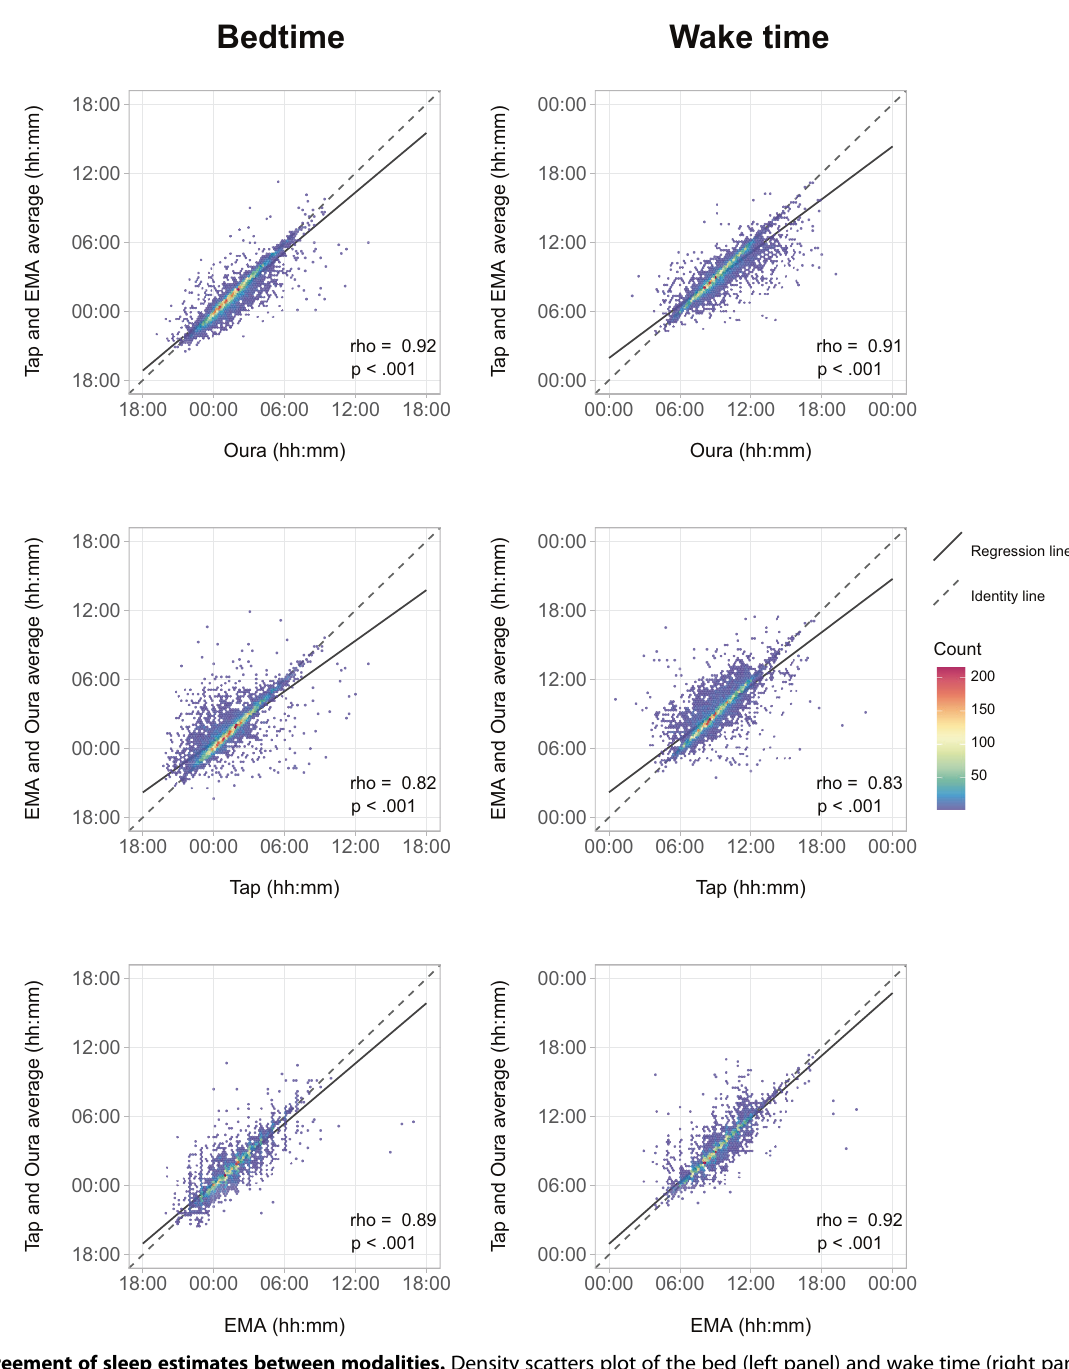
Fig. 2 Agreement of sleep estimates between modalities. Density scatters plot of the bed (left panel) and wake time (right panel) estimates from each modality ( x -axis) against estimates obtained from the average of the other two modalities ( y -axis). Correlation coef fi cients are stated for each of the subplots (nights with all three modalities, n = 7581). The dashed line indicates the identity line where there is complete agreement between cluster solutions remained stable when a range of different discrepancy thresholds was used (1.5, 2, and 2.5 h; see Supple- mentary Fig. 1 and Supplementary Table 1). Cluster 1 ( n = 467) consisted of nights with delayed sleep timings across all modalities and later Oura wake times relative to the other clusters. From the corresponding discrepancy data, we observed that Oura ’ s wake time estimates for this cluster were later in comparison to the other modalities (Fig. 3b). On a Cluster 1 night, EMA wake time coincided with Tap-based wake time (Fig.